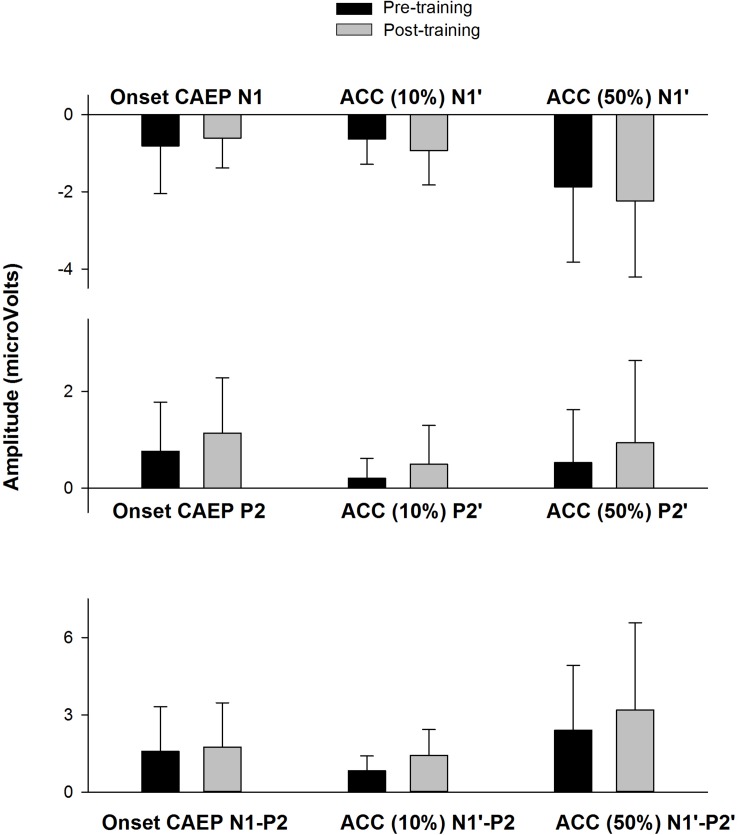
The means of the response amplitude at pre- and post-training testing (n = 9). The error bar indicates 1 standard deviation. The peak amplitudes (pre-training data in black, post-training data in gray) are displayed for the onset CAEP (N1, P2, N1–P2) and the ACC (N1′, P2′, and N1′–P2′) for the 10% and 50% change, respectively.